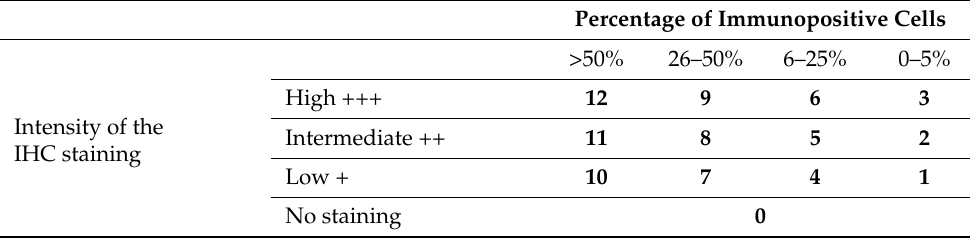
Table 1. The assessment of the expression coefficient of analyzed markers in neoplastic cells based on the intensity of the immunohistochemical staining and the percentage of the immunopositive cells . Percentage of Immunopositive Cells >50% 26–50% 6–25% 0–5% High +++ 12 9 3 Intensity of the Intermediate ++ 11 IHC staining Low + No staining